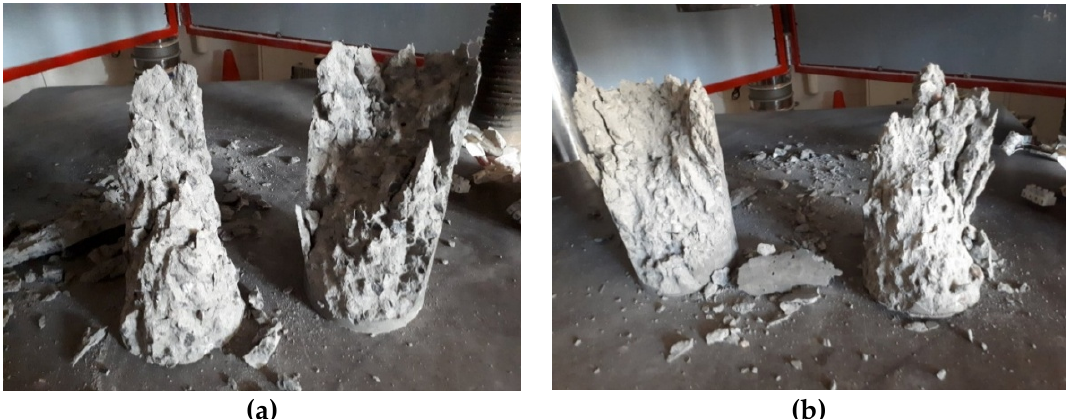
Figure 15. ( a , b ) Partial cone/shear failure of samples subjected to compression Figure 15. (a,b) Partial cone/shear failure of samples subjected to compression testing.